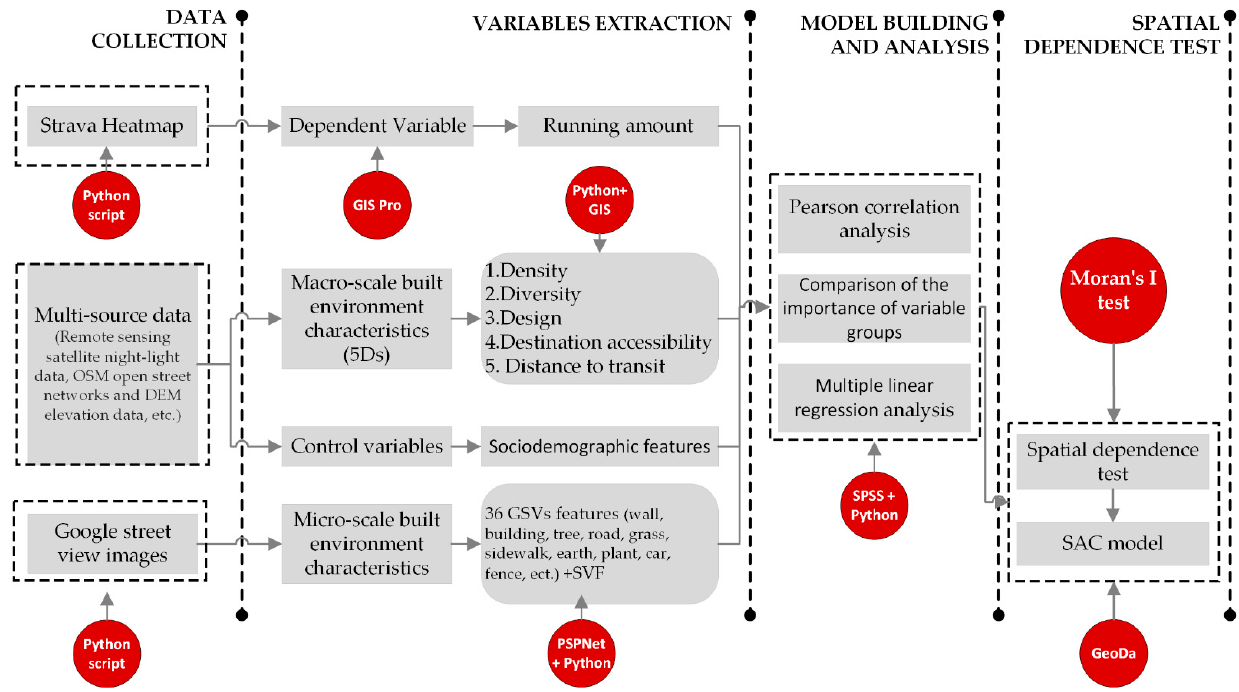
Figure 2. The analytical framework of this